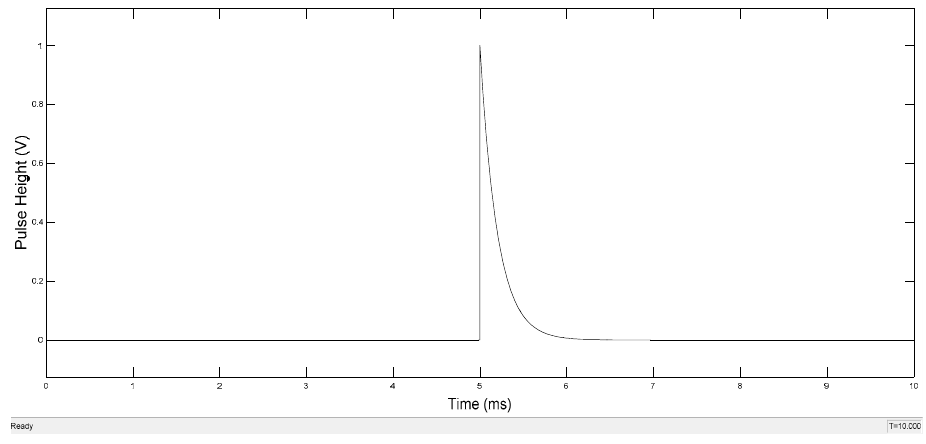
Figure 3. The typical CSA output.